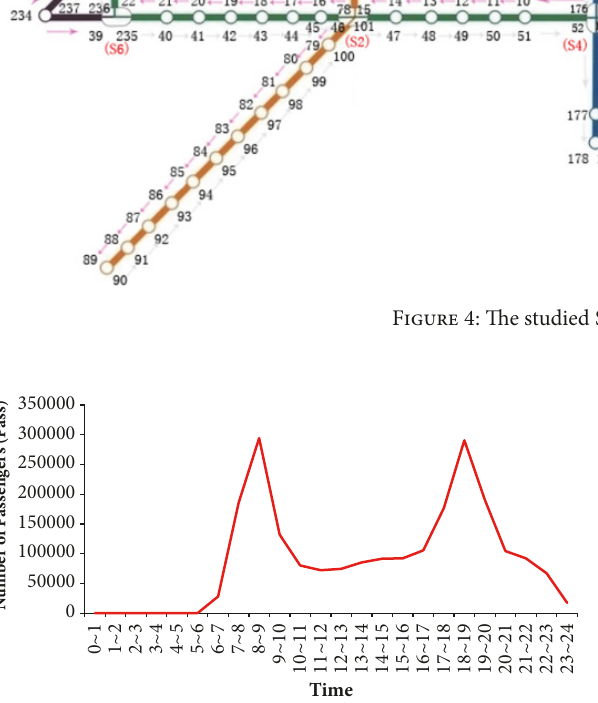
Figure 5: Temporal distribution of